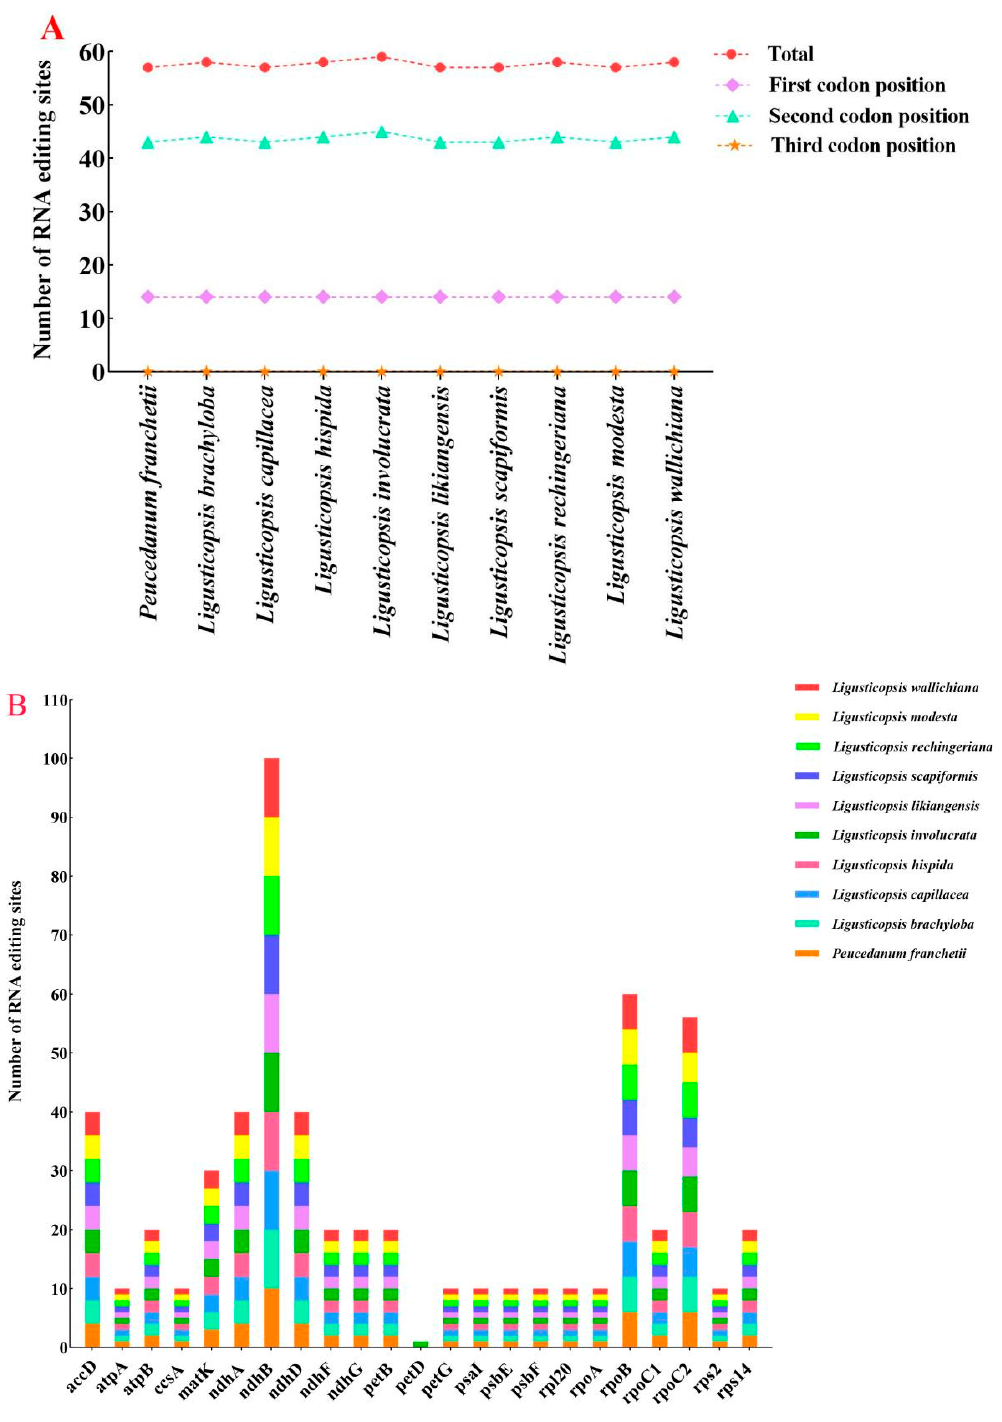
Figure 4. The RNA editing sites in ten plastomes. ( A ) Numbers of RNA editing sites distributed in different codon positions; ( B ) numbers of RNA editing sites presented in genes.